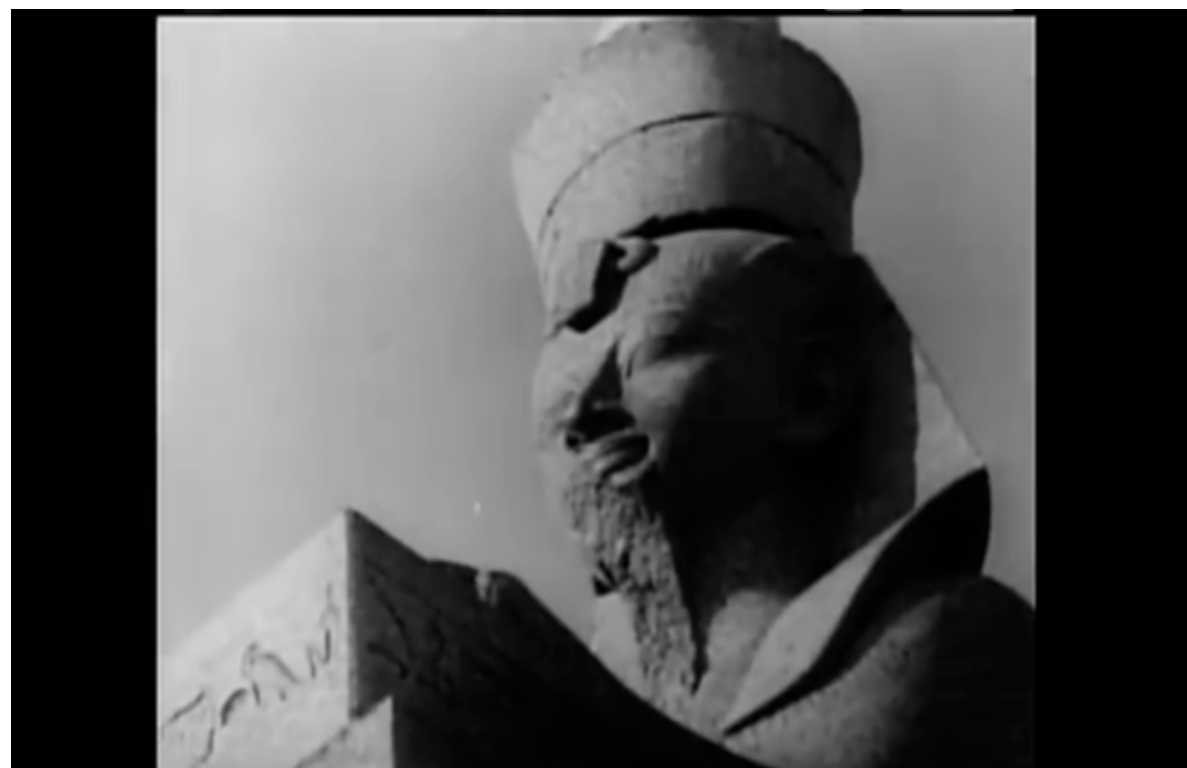
Figure 1. Screenshot of scene in Sergei Eisenstein’s film October .